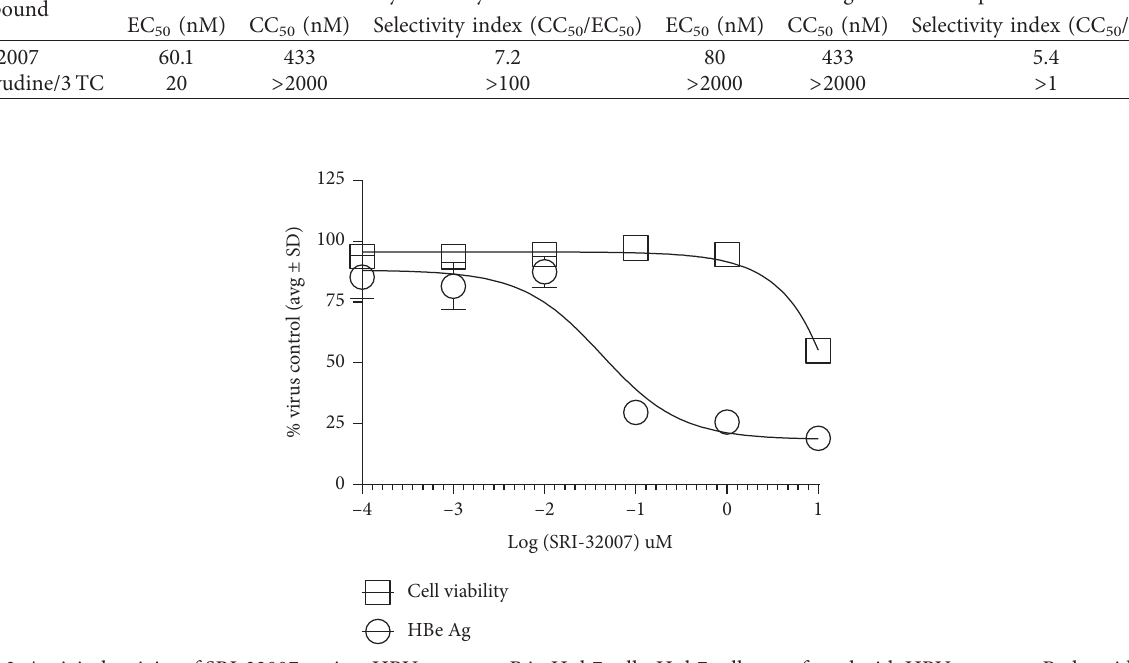
Table 1: Activity of SRI-32007 in the HBV virus yield assay in HepG2.2.2.15 cells. Compound